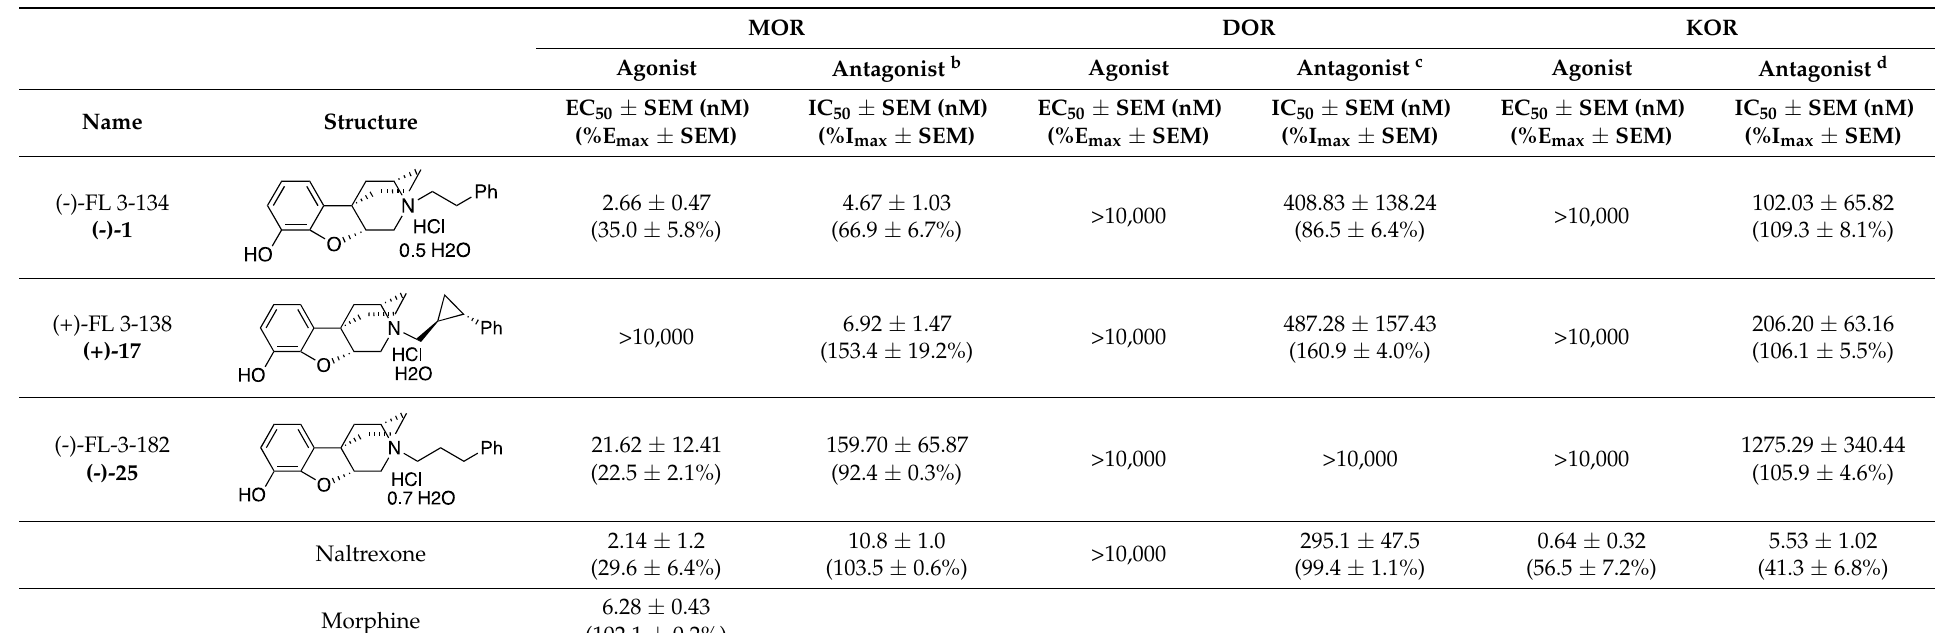
Table 2. Opioid receptor activity measured in the forskolin-induced cAMP accumulation assay a .